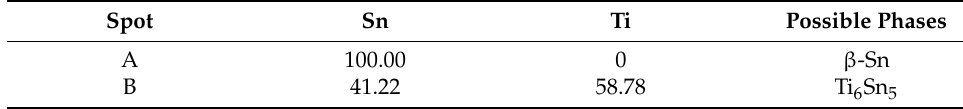
Table 2. EDS chemical analysis of the regions marked in Figure 3b